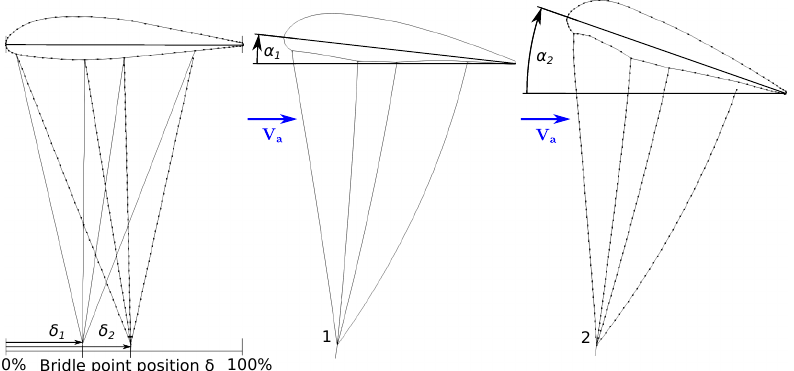
Figure 4. Trim configurations 1 and 2 for the initial configuration and shape of the kite ( left ), and for steady-state flight ( center and right ) in the symmetry plane of the kite. Adapted from